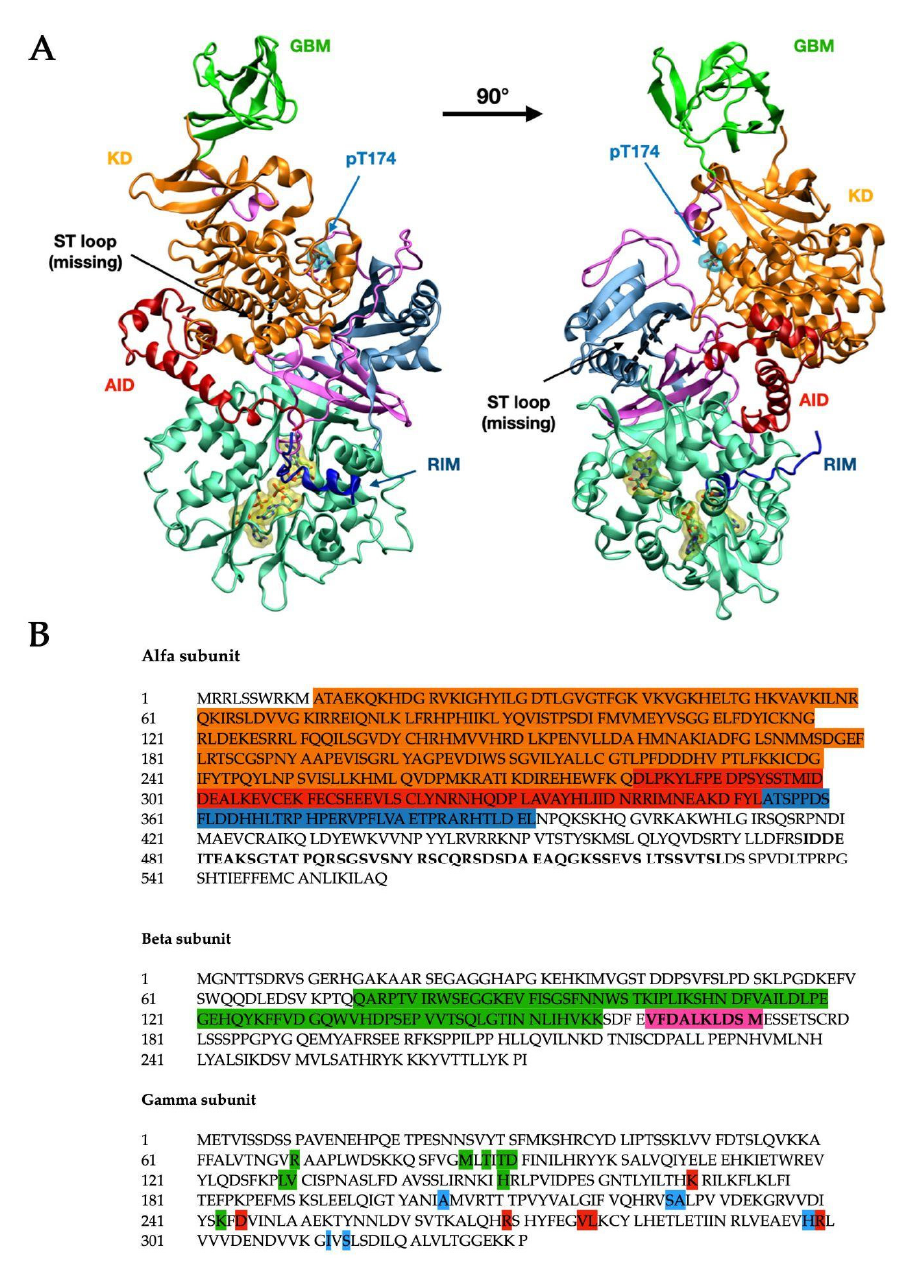
Figure 2. Structural visualization ( A )and primary sequence ( B ) of human AMPK (PDB ID: 4RER [4]). The structure ( A ) is composed of the α 1 subunit (blue-grey) and the β 2 (pink) and γ 1 (light teal green, with three bound AMP residues) regulatory subunits. The α subunit presents the kinase domain (KD, orange), the autoinhibitory domain (AID, red), and the residue inhibitory motif (RIM, blue). The black dashed line indicates the position of the ST loop, while the phosphorylated Thr-174 (Thr-172 in α 2) is shown with the cyan surface. On the β subunit, the glycogen-binding domain (GBM) is shown in bright green. The numbers of starting and ending residues for each highlighted domain are reported in Table 1. In the primary sequence ( B ), the domains are highlighted in the same color code: the α 1 subunit (UniProt: Q13131) shows the KD domain (orange), AID (red), and RIM (blue), and the sequence for the ST loop has been bolded. The β 2 subunit (UniProt: O43741) shows the GBM domain (green) and the sequence for the ADaM site (bolded, highlighted in pink). In the γ 1 subunit (UniProt: P54619), all residues belonging to the respective CBM have been highlighted using the same color code as shown in Figure 1 (green: CBM1, red: CBS3, blue: CBS4).